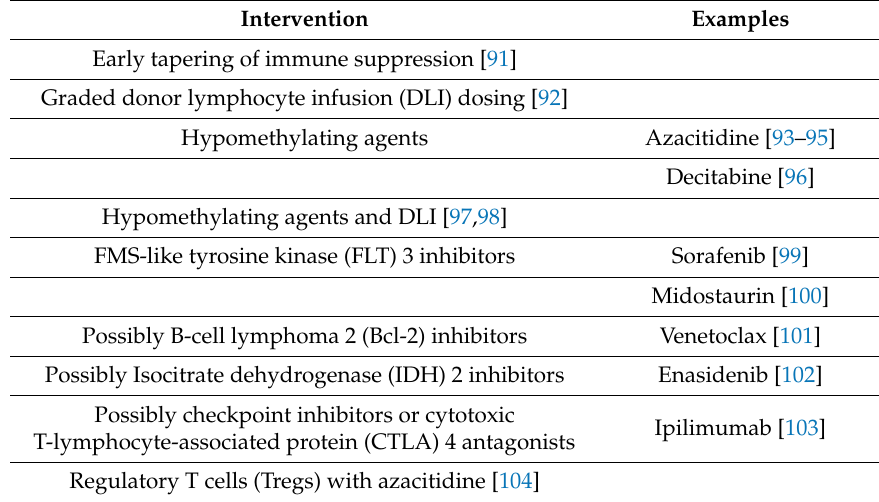
Table 3. Representative Modalities Utilized Post-Transplant to Prevent or Treat